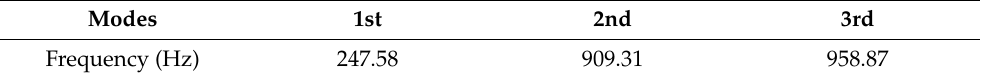
Table 4. Natural frequency under different magnetic fields.